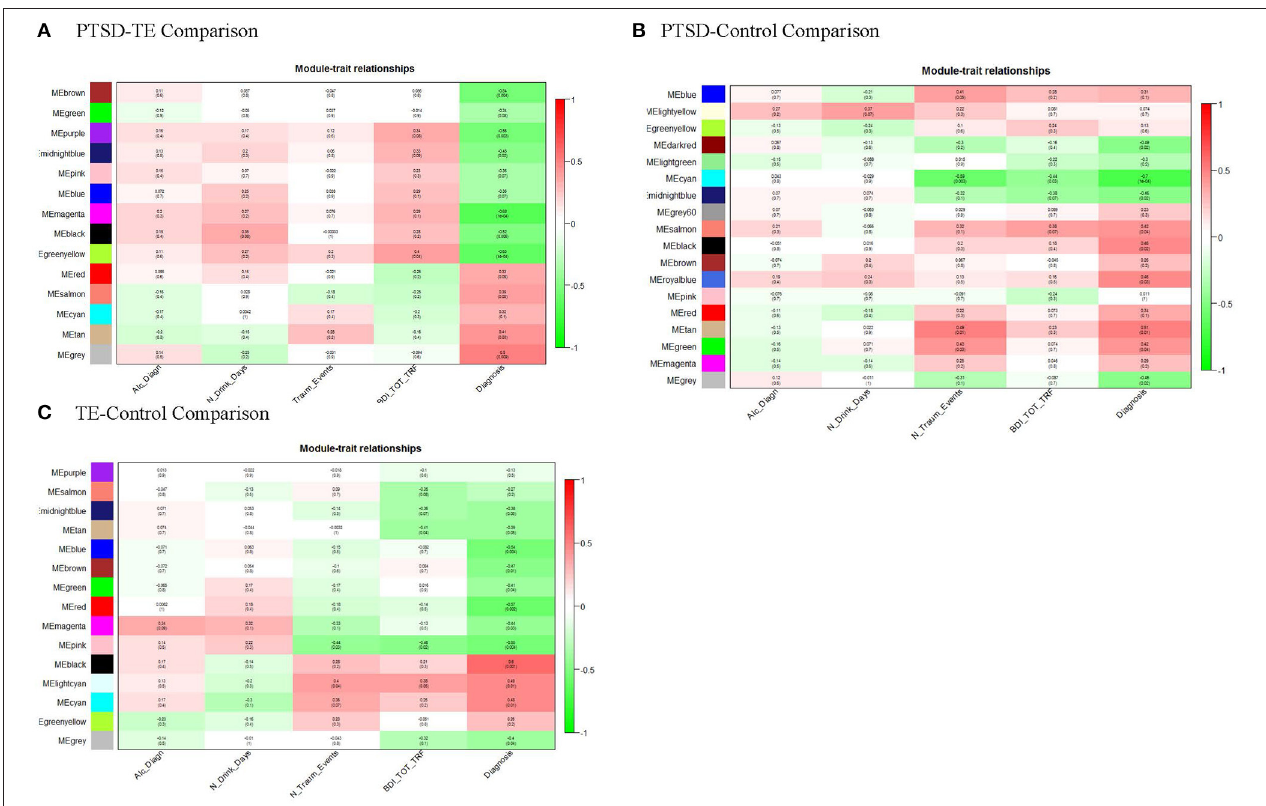
FIGURE 1 | Module-trait relationships. Module MEs are correlated (Pearson) to PTSD/TE case-status (Diagnosis), to identify disease-relevant modules, and to alcohol drinking (Alc_Diagn), number alcohol drinks per day (N_Drink_Days), the number of traumatic events (N_Traum_Events), and Beck depression scale (BDI_TOT_TRF) to assess for confounding of these variables. P -values shown are unadjusted for multiple testing. (A) After adjusting for number of modules tested, ME brown , ME purple , ME magenta , and ME greenyellow , are significantly correlated with PTSD/TE status (Diagnosis); (B) After adjusting p -values for number of modules tested, only ME cyan , module is significantly correlated with PTSD/Cont status (Diagnosis). (C) Similarly, after adjusting p -values for number of modules tested, ME blue , ME red , ME pink , and ME black modules are significantly correlated with TE/Cont status